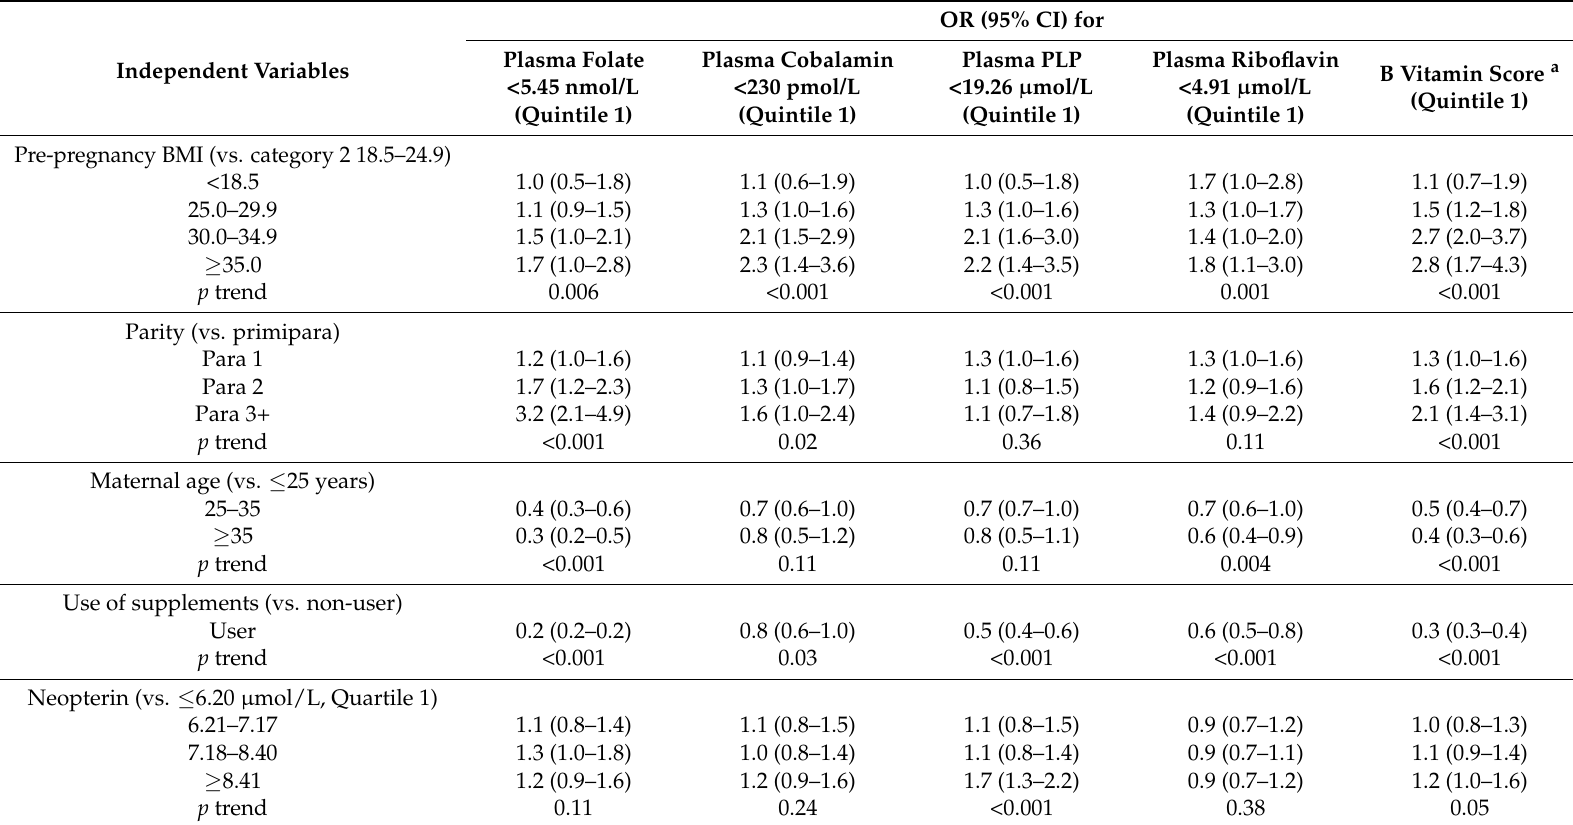
Table 4. OR for low B vitamin status according to maternal factors, by logistic regression ( n = 2797).